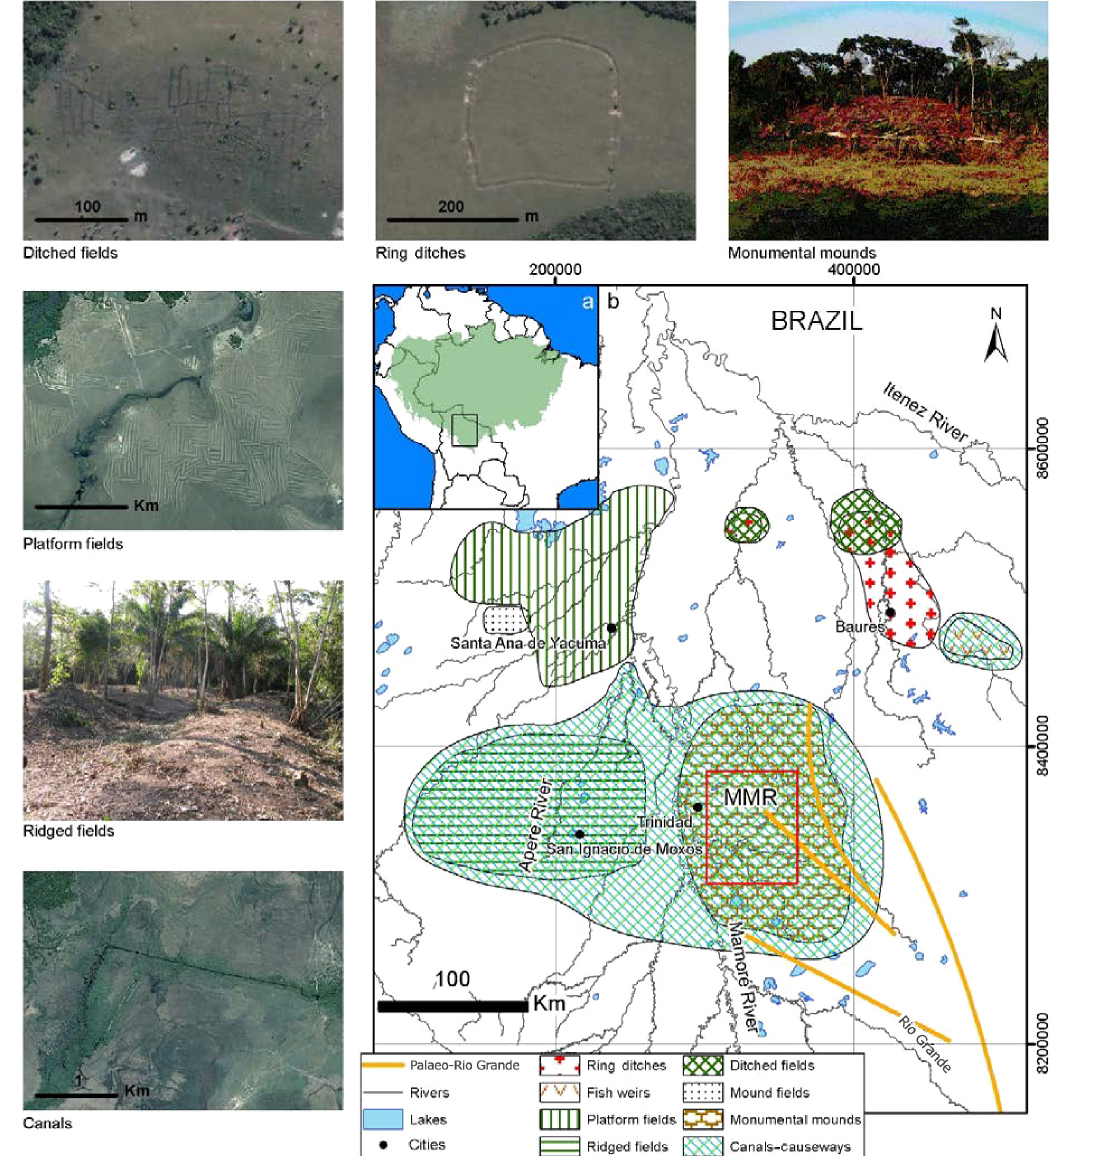
Figure 1. Different pre-Columbian earthworks that exist in the Llanos de Moxos and their spatial distribution (adapted from Lombardo et al., 2011b). Platform, ridged and ditched fields are different types of pre-Columbian agricultural raised fields. The red box defines the area in Fig.